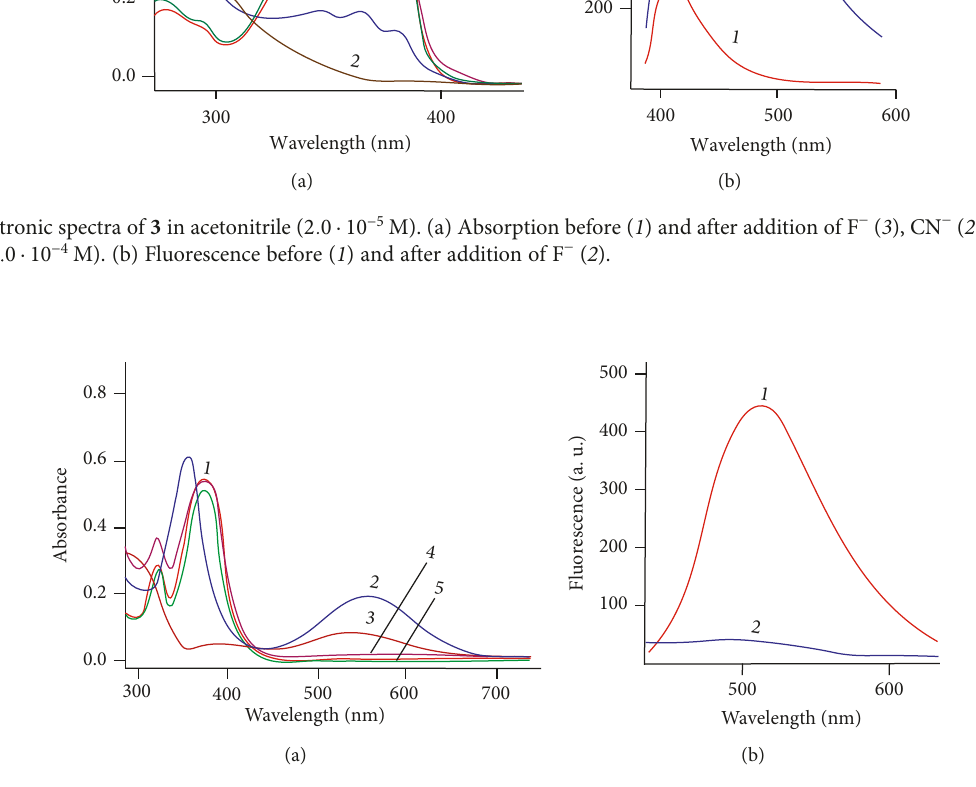
fl uorescence intensity ( I max ) and